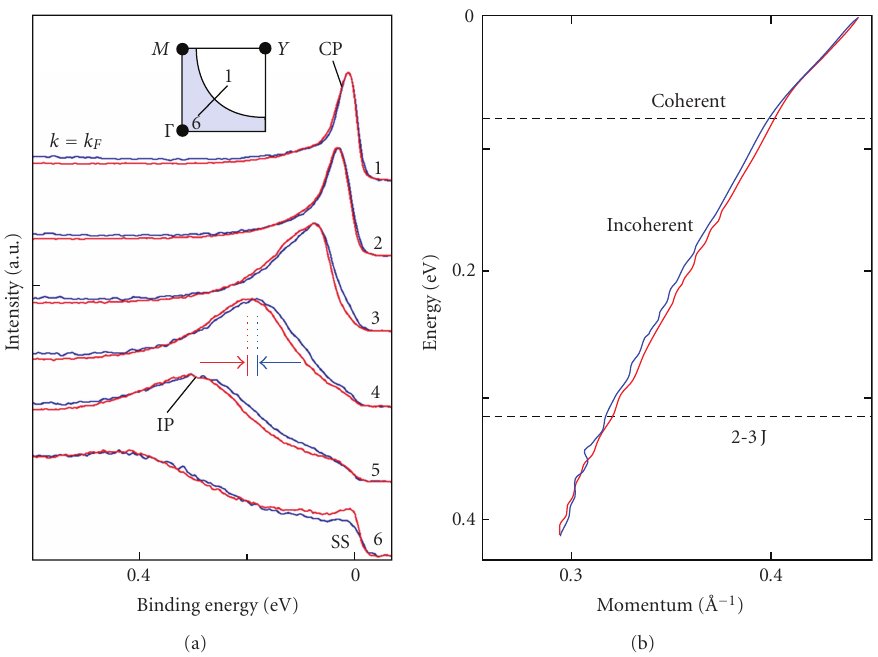
Figure 7: (a) EDCs taken on optimally doped Bi 2 Sr 2 CaCu 2 O 8+ δ samples with di ff erent oxygen isotopes at T = 25K. The EDCs are from the same cut as in Figure 6 and indicated by the inset. The sharp coherent peak (CP) near E F and broader incoherent peak (IP) at higher energy are identified. The CP has nearly no isotope dependence while the IP has a more substantial IE, most strongly seen in curve 4. The small peak at E F in curve 6 is the well-known superstructure (SS) replica of the main band. This figure is from [33]. (b) MDC dispersion taken to higher binding energy indicating that the IE, more pronounced for the IP as in (a), disappears again above roughly 2-3 times the antiferromagnetic coupling energy, J .